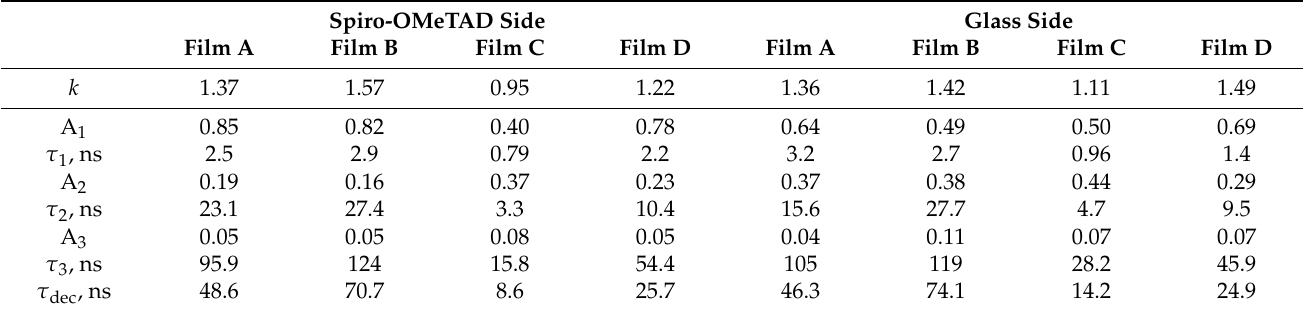
Table 2. Results of PL spectra analysis. k is the slope of log I PL versus log P curve; A i and τ i are the amplitude and the decay time constant of the i th term in Equation (1); τ dec is average decay time calculated using Equation